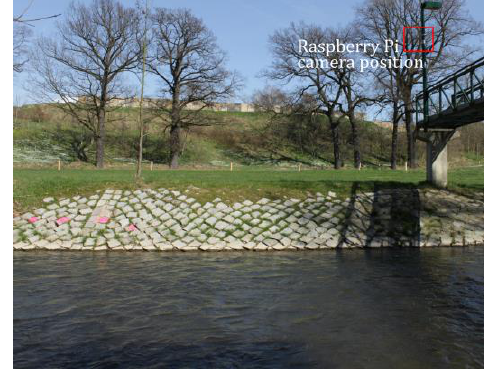
Figure 1. Position of the camera used at the Wesenitz river. The dataset was acquired with the 5-megapixel sensor Raspberry Pi Camera Module v2.1 connected to the corresponding single-board computer Raspberry Pi Zero. The image resolution is 2592 x 1444 pixels and the pixel pitch amounts 1.4 μm. The camera is equipped with a fixed lens with a focal length of 2.9 mm resulting in a wide field of view at the investigated river section. The Pi camera was calibrated prior to the installation using a scaled temporary calibration field. Image